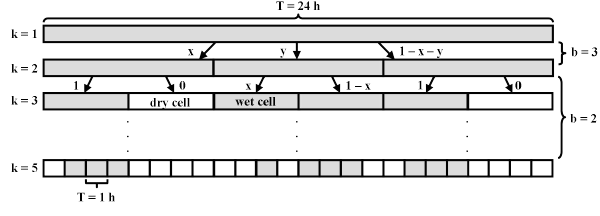
Fig. 1. Schematic of a cascade process, as implemented in the two cascade models presented in this paper. Cells of a cascade level k with timescale T k are branched into a number of child cells, as de- fined by the branching number b , at the next cascade level k + 1 and the rainfall volume of wet cells is redistributed among them accord- ing to rules defined by the cascade